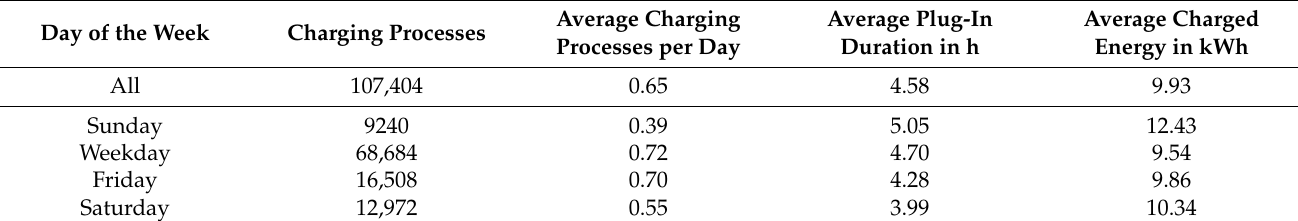
Table 2. Characteristics of the processed data classified by type-days.